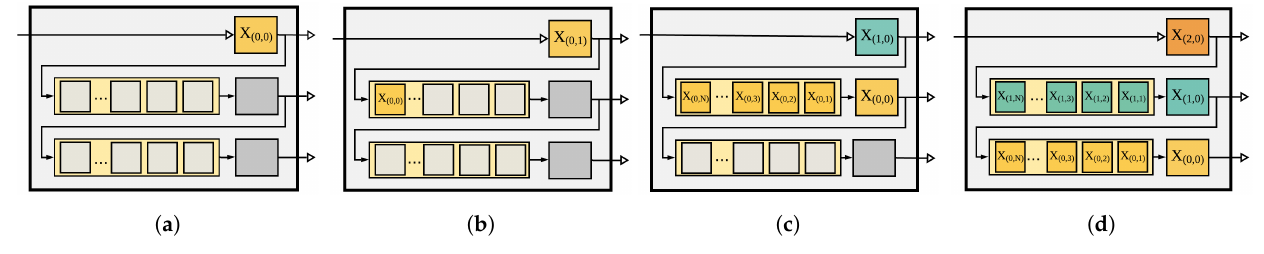
Figure 15. Initialization of the line buffers.